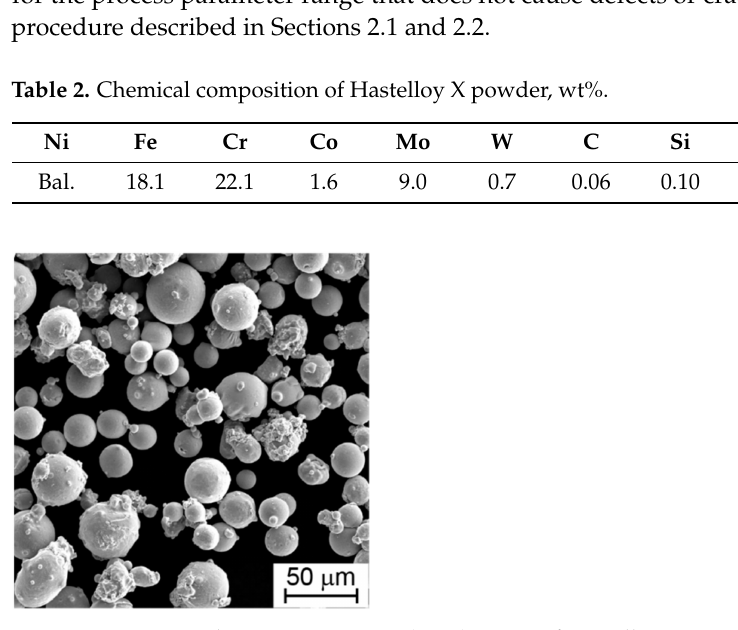
Figure 5. Scanning electron microscope (SEM) image of Hastelloy-X powder.